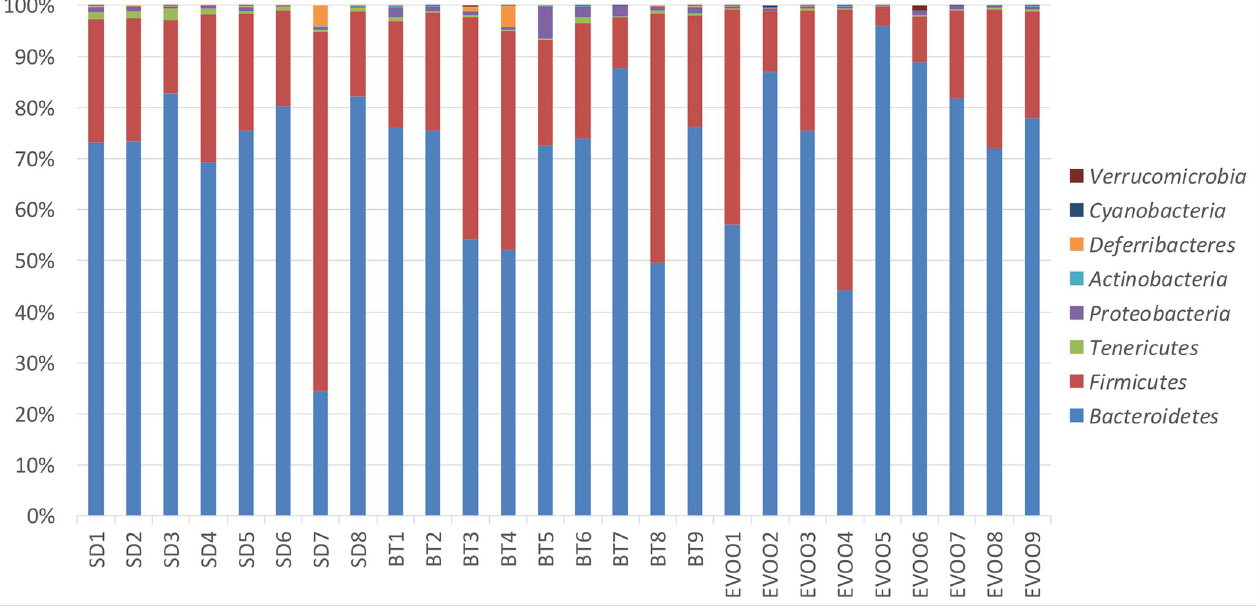
PLOS ONE | https://doi.org/10.1371/journal.pone.0271634 August 16,